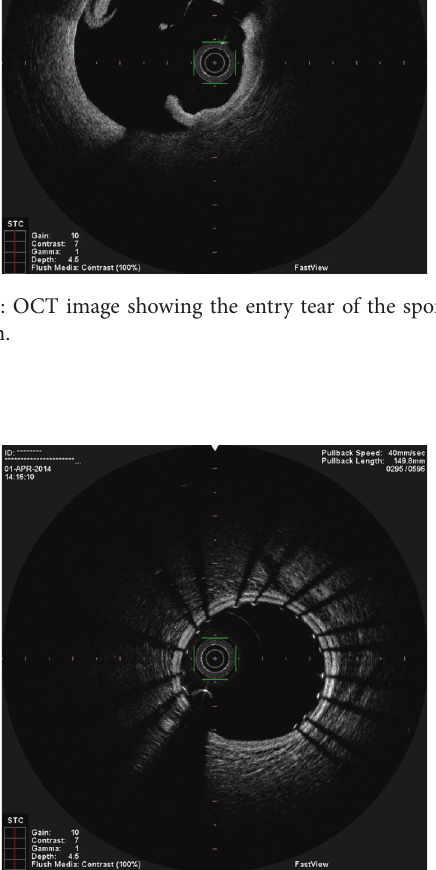
Figure 5: OCT performed after stent implantation showing good apposition.